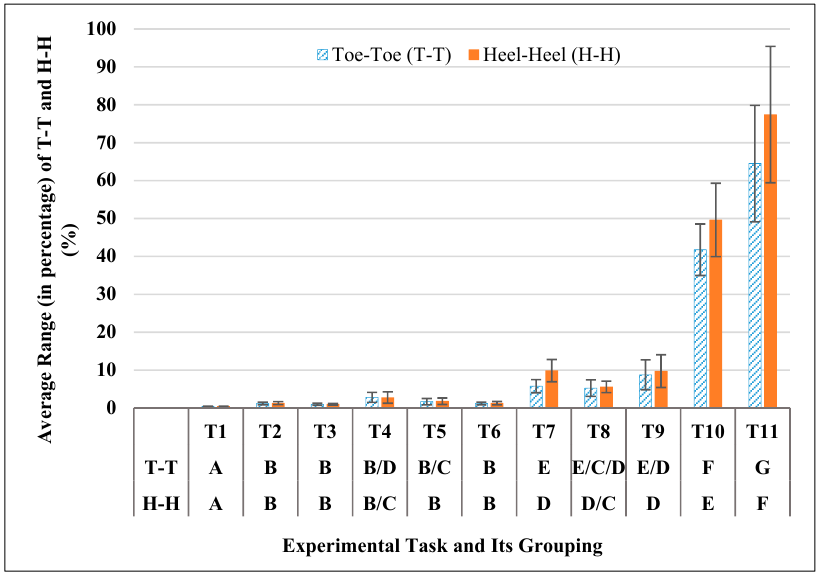
Figure 9. Average range (in percentage, PARG) of Xsens-based side lengths (Toe-Toe, Heel-Heel) during each experimental task and post-hoc grouping result (Same letters indicate no significant difference).